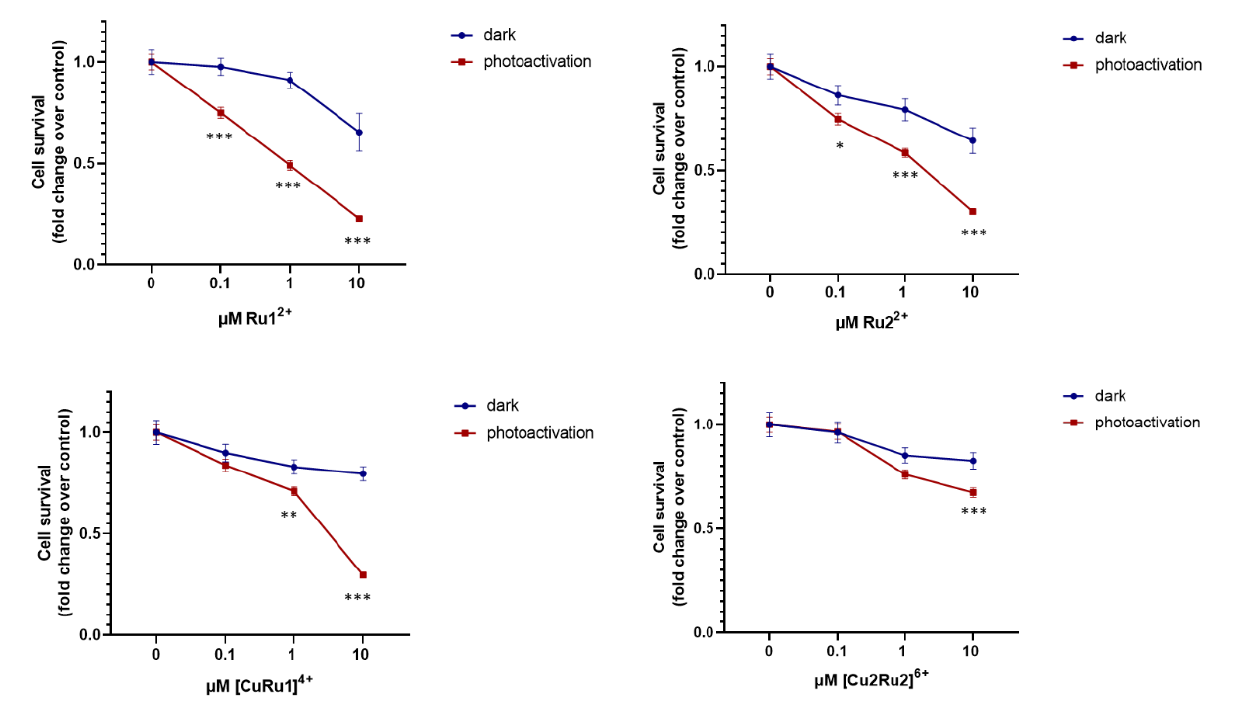
Figure 3. Dose-dependent effect of Ru(II) complexes on cell survival of ovarian cancer cells after photosensitization. A2780 were incubated for 24 h in the presence of Ru(II) complexes, Ru1 2+ , Ru2 2+ , [Cu Ru1 ] 4+ and [Cu 2 Ru2 ] 6+ at the following concentrations (0, 0.1 µM, 1 µM, 10 µM) in serum-deprived culture media (RPMI with BSA 0.1%). Photoactivation for 20 min, as described in the Materials and Methods section. MTT reduction tests were performed in triplicate, representative of three independent experiments with similar results. Data reported are mean ± SD, fold change of absorbance at 570 nm over untreated control. The effect of photoactivation of Ru(II) complexes on the inhibition of cell survival was statistically significant according to two-way ANOVA followed by Bonferroni post hoc test. * p < 0.05, ** p < 0.01, *** p < 0.001.